Question: Write a single sentence explaining what this figure depicts.
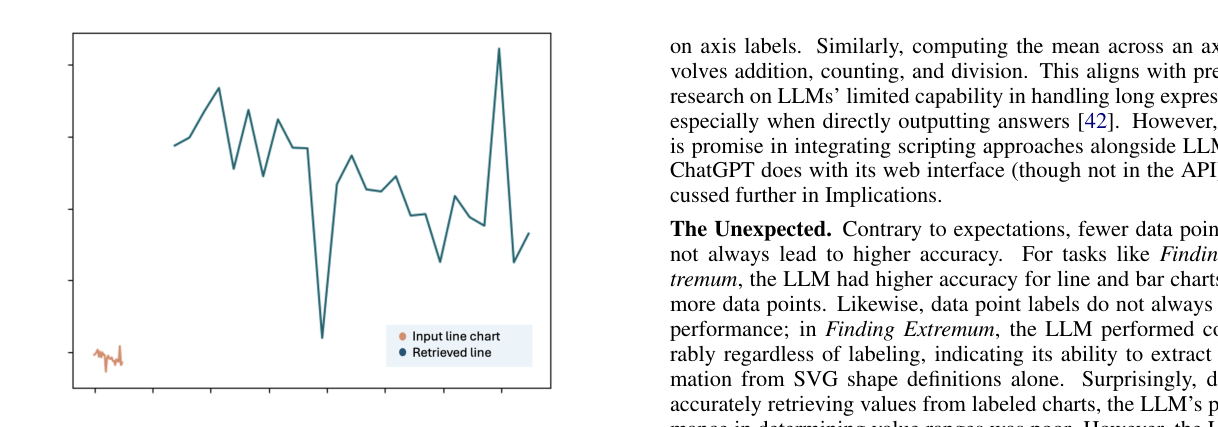
Answer: Comparison of retrieved data points (teal) extracted by the LLM directly from SVG position definitions and the original data points (orange).